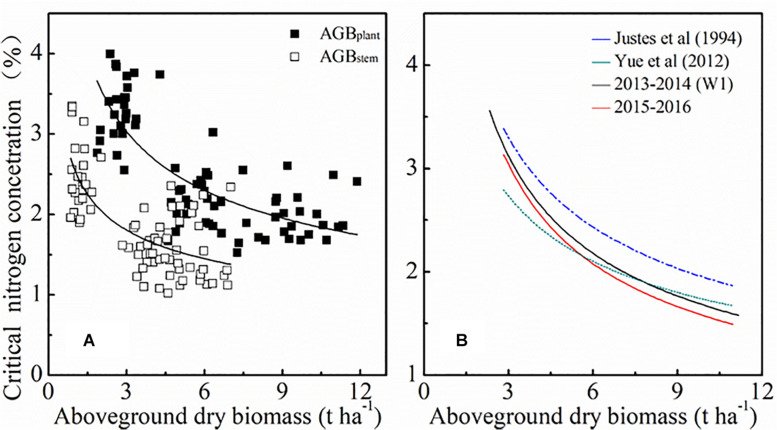
Comparison of standard Nc dilution curves for different plant organs (A) and produced by different studies (B). Blue line represents the standard Nc dilution curve of Justes et al. (1994) (Nc=535×AGB0.44). Brown line represents the standard Nc dilution curve of Yue et al. (2012) (Nc=4.15×AGB–0.38). Black line represents the standard Nc dilution curve of the current study [2013 ∼ 2014 (Wl): Nc=5.35×AGB–0.53]. Red line represents the standard Nc dilution curve of the current study (2014 ∼ 2015: Nc=5.30×AGB–0.50).